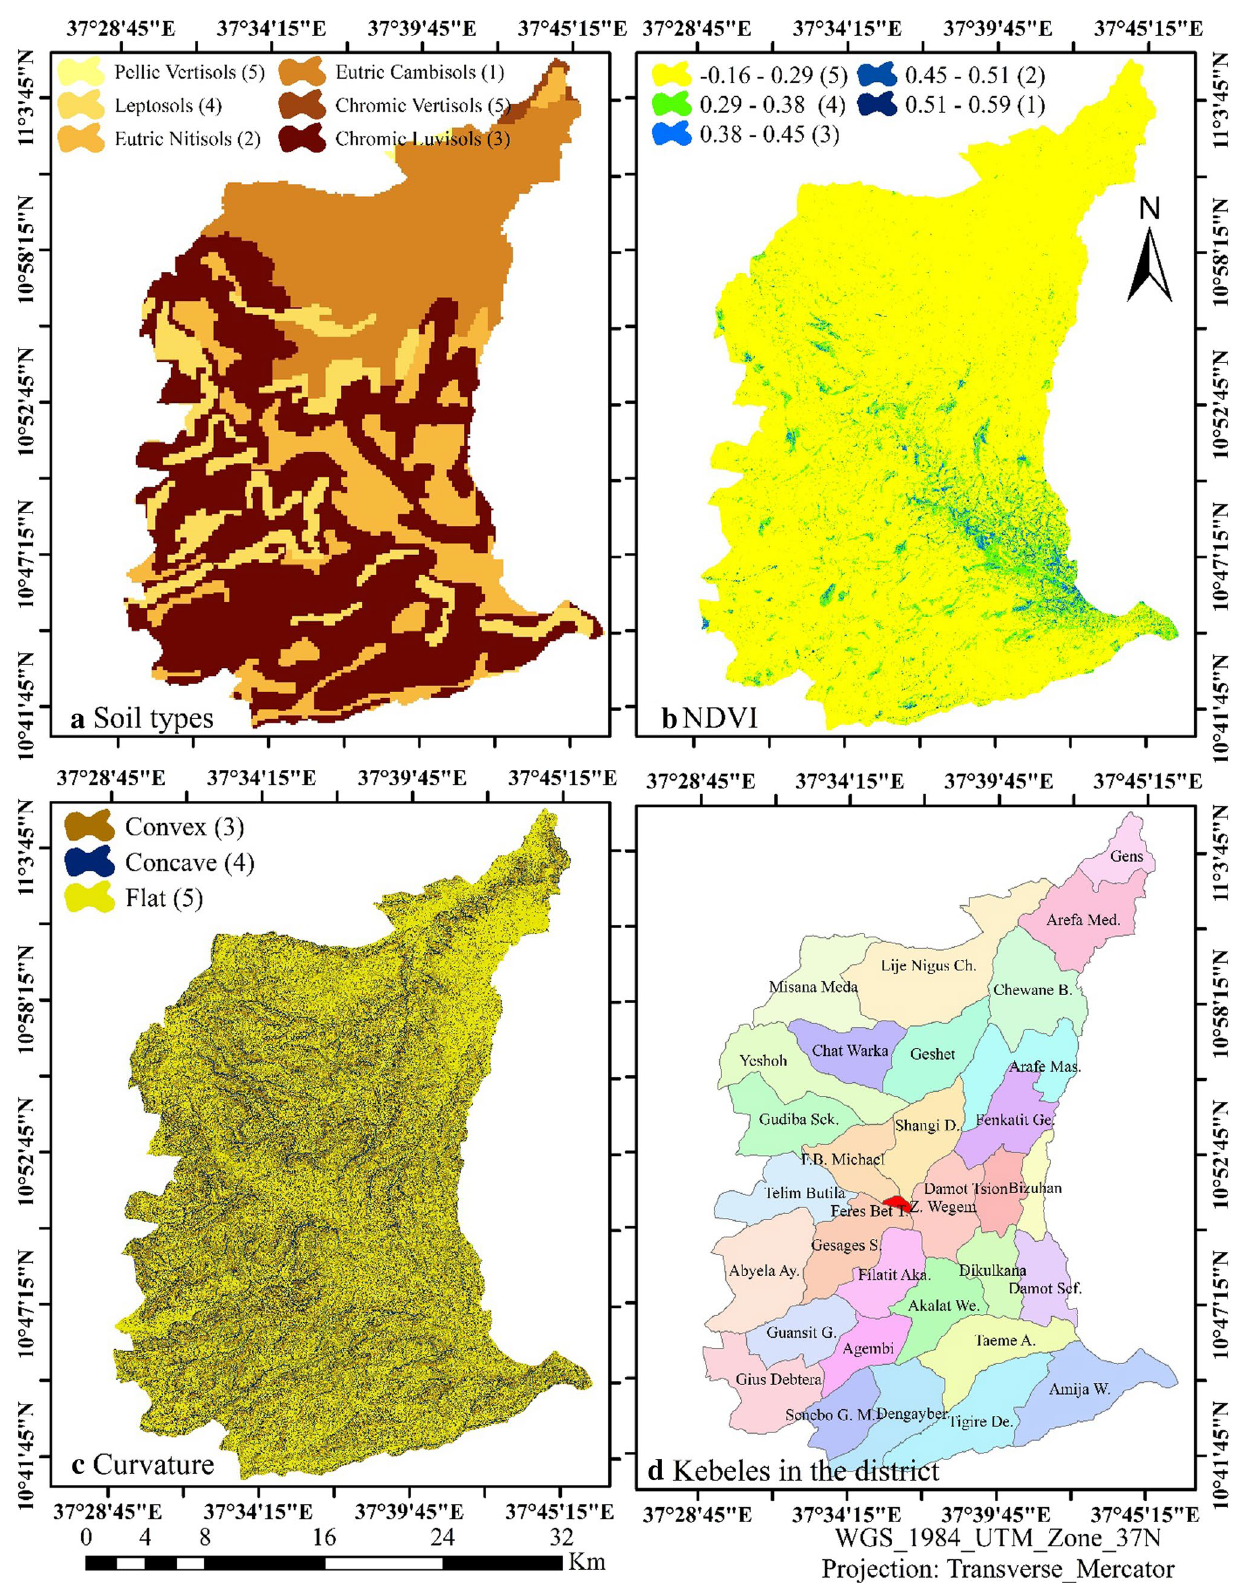
Fig. 5 Soil type a , Normalized Difference Vegetation Index b , surface curvature c , and kebeles of the district d (kebele is the lowest administra- tive unit in